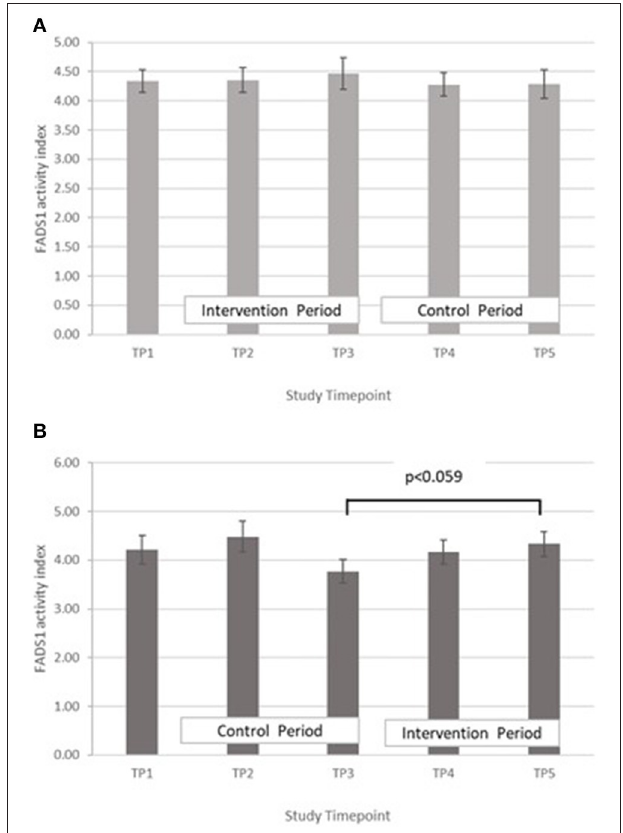
FIGURE 6 | (A) Fatty acid desaturase 1 activity measured in Group A at baseline (T1), week 4 of period 1 (T2), week 8 of period 1 (T3), week 4 of period 2 (T4) and week 8 of period 2 (T5). Bars indicate estimated marginal means with standard error. (B) Fatty acid desaturase 1 activity measured in Group B at baseline (T1), week 4 of period 1 (T2), week 8 of period 1 (T3), week 4 of period 2 (T4) and week 8 of period 2 (T5). Bars indicate estimated marginal means with standard error.